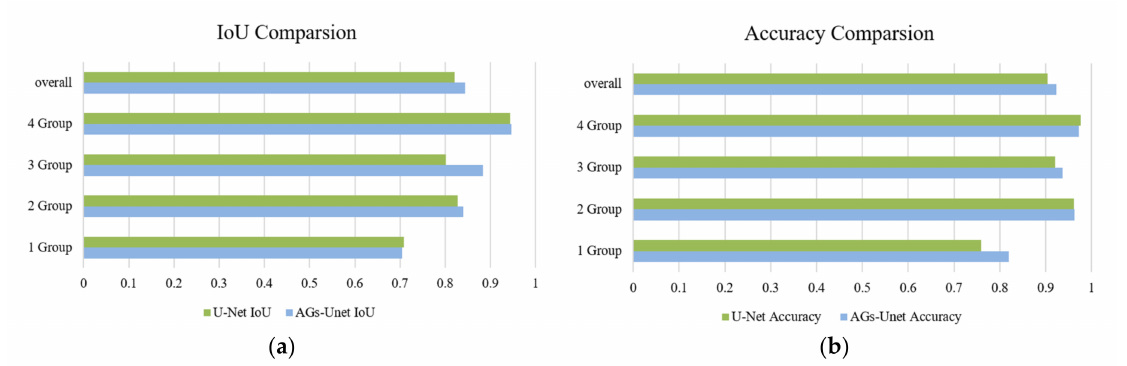
Figure 7. Comparison of IoU and Accuracy between U-Net and AGs-Unet models. The left figure ( a ) shows the comparison results of IoU between U-Net and AGs-Unet models while the right figure ( b ) shows the comparison results of Accuracy between U-Net and AGs-Unet